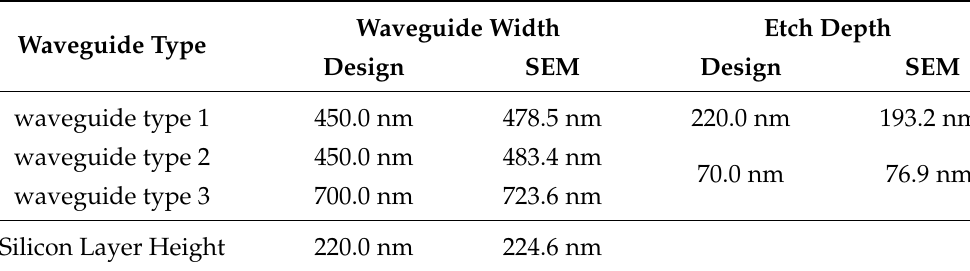
Table 1. Comparison of design values and values measured with scanning electron-beam microscopy (SEM) for the geometrical waveguide